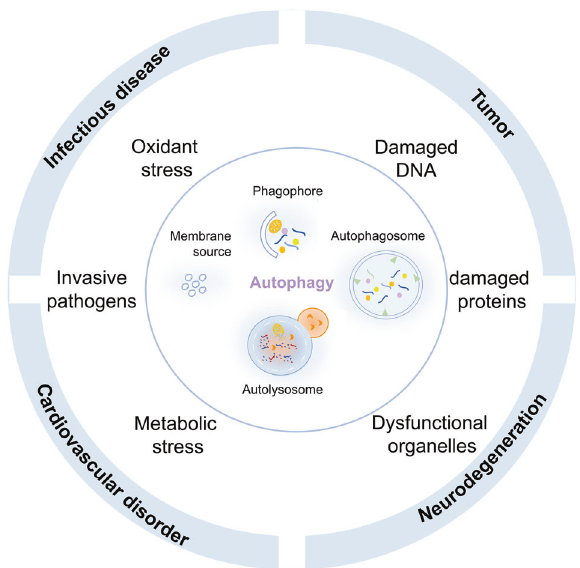
Fig. 1 Autophagy and diseases. Autophagy dysregulation and tumor, in fl ammatory disease, neurodegenerative disease, cardiovas- cular